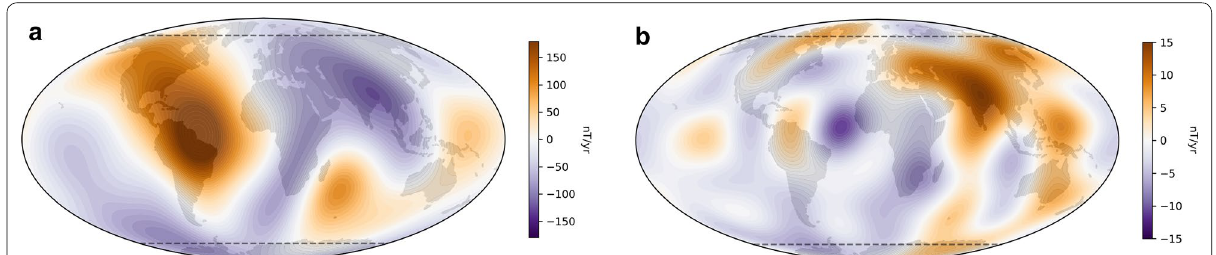
Fig. 7 a Radial SV in 2020 of our candidate model and b the difference to IGRF-13 at the Earth’s surface for ℓ ≤ 8